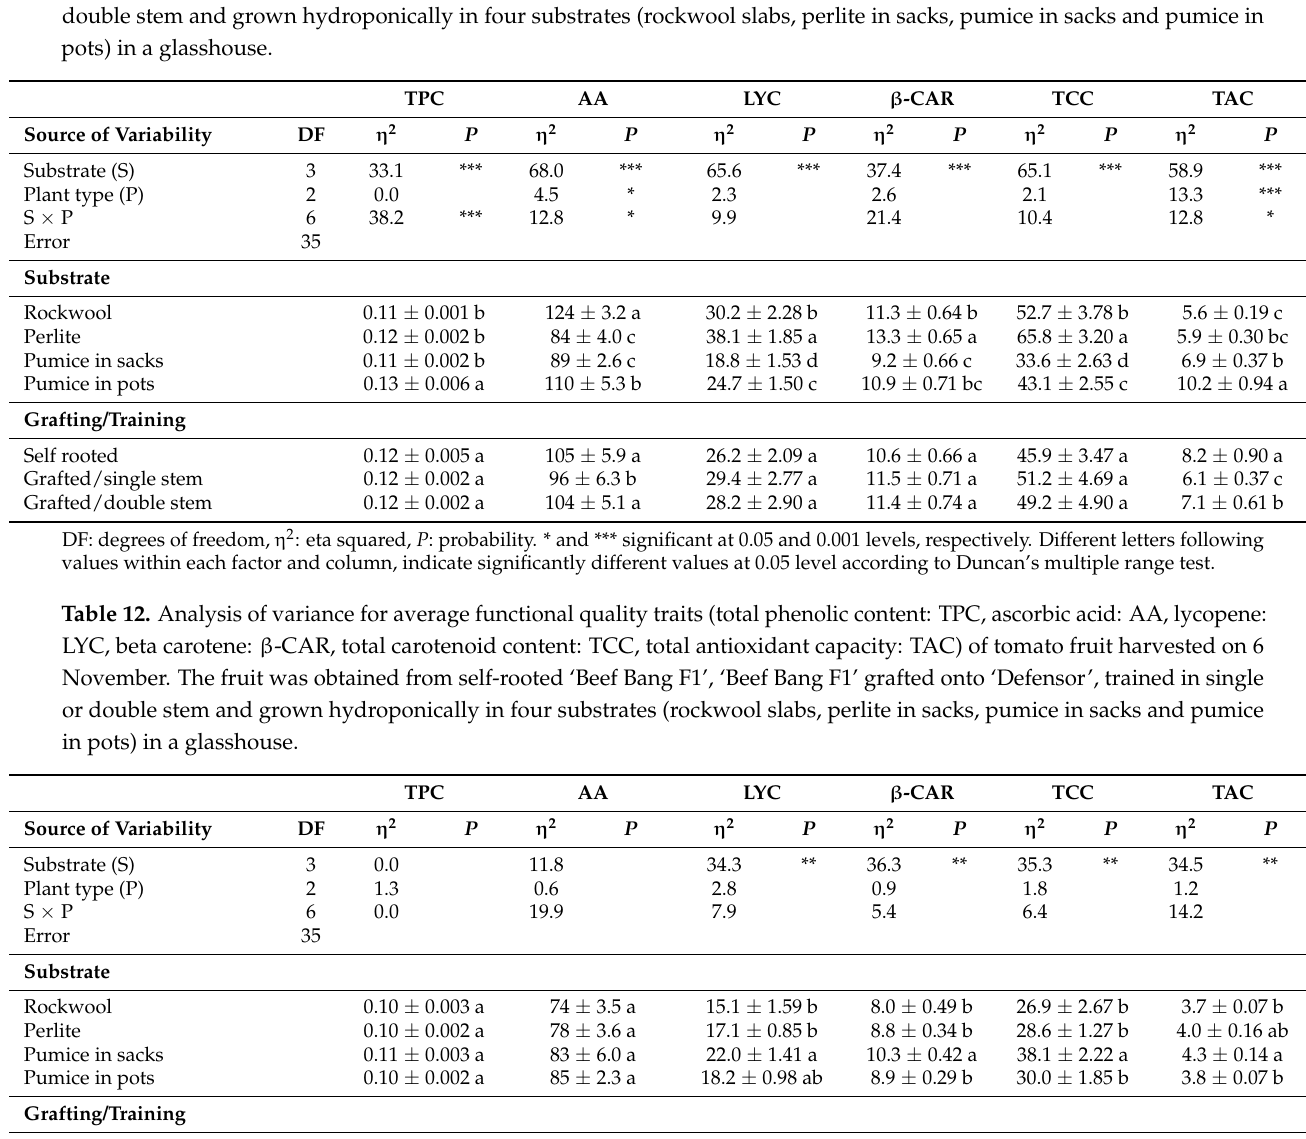
Table 11. Analysis of variance for average functional quality traits (total phenolic content: TPC, ascorbic acid: AA, lycopene: LYC, beta carotene: β -CAR, total carotenoid content: TCC, total antioxidant capacity: TAC) of tomato fruit harvested on 31 July. The fruit was obtained from self-rooted ‘Beef Bang F1’, ‘Beef Bang F1’ grafted onto ‘Defensor’, trained in single or double stem and grown hydroponically in four substrates (rockwool slabs, perlite in sacks, pumice in sacks and pumice in